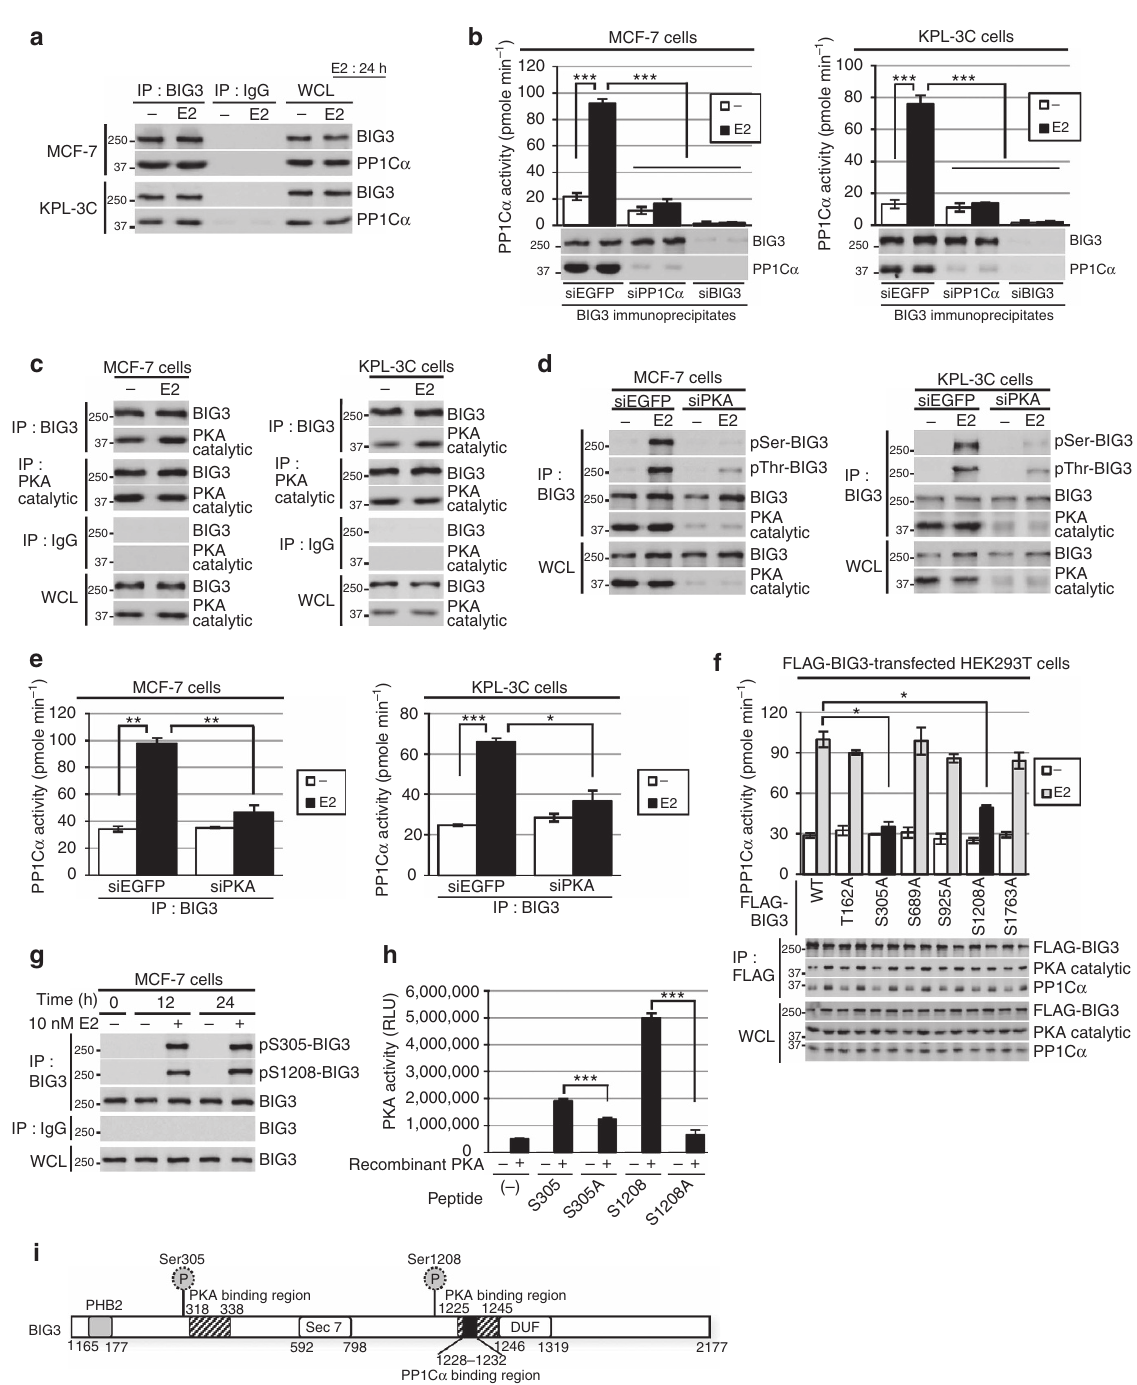
Figure 1 | BIG3 phosphorylation functions as a regulatory subunit of PP1C a . ( a ) Interaction of endogenous PP1C a with BIG3 in MCF-7 and KPL-3C cells after E2 stimulation for 24h. ( b ) Effects of siPP1C a and siBIG3 on phosphatase activity of BIG3 immunoprecipitates in MCF-7 and KPL3C cells. These data represent the means ± s.e.m. of three independent experiments. ( c ) Interaction of endogenous PKA catalytic subunit with BIG3 after E2 stimulation for 24h in MCF-7 and KPL-3C cells. ( d ) The inhibitory effects of siPKA on BIG3 phosphorylation in MCF-7 and KPL-3C cells. Representative results are shown from one of three experiments. ( e ) The inhibitory effects of siPKA on PP1C a phosphatase activity of BIG3 immunoprecipitates after E2 stimulation for 24h in MCF-7and KPL-3C cells. These data represent the means ± s.e.m. of three independent experiments. ( f ) Analysis of PP1C a phosphatase activity to identify the phosphorylation sites in BIG3 by PKA. The indicated FLAG-tagged BIG3 mutants (T162A, S305A, S689A, S925A, S1208A and S1763A) and HA-tagged ER a construct-transfected HEK293T cells were immunoprecipitated using an anti-FLAG antibody. The immunoprecipitates were immunoblotted, and the phosphatase activity against p NPP was measured. Each PP1C a activity was normalized to the PP1C a signal intensity of immunoprecipitates in FLAG-tagged BIG3 (WT)-transfected HEK293T cells. These data represent the means ± s.e.m. of three independent experiments. ( g ) BIG3 phosphorylation at S305 and S1208 at the indicated time points after E2 stimulation. ( h ) In vitro PKA activation assay of BIG3 using engineered peptides representing S305 and S1208. These data represent the means ± s.e.m. of three independent experiments. ( i ) The schematic representation